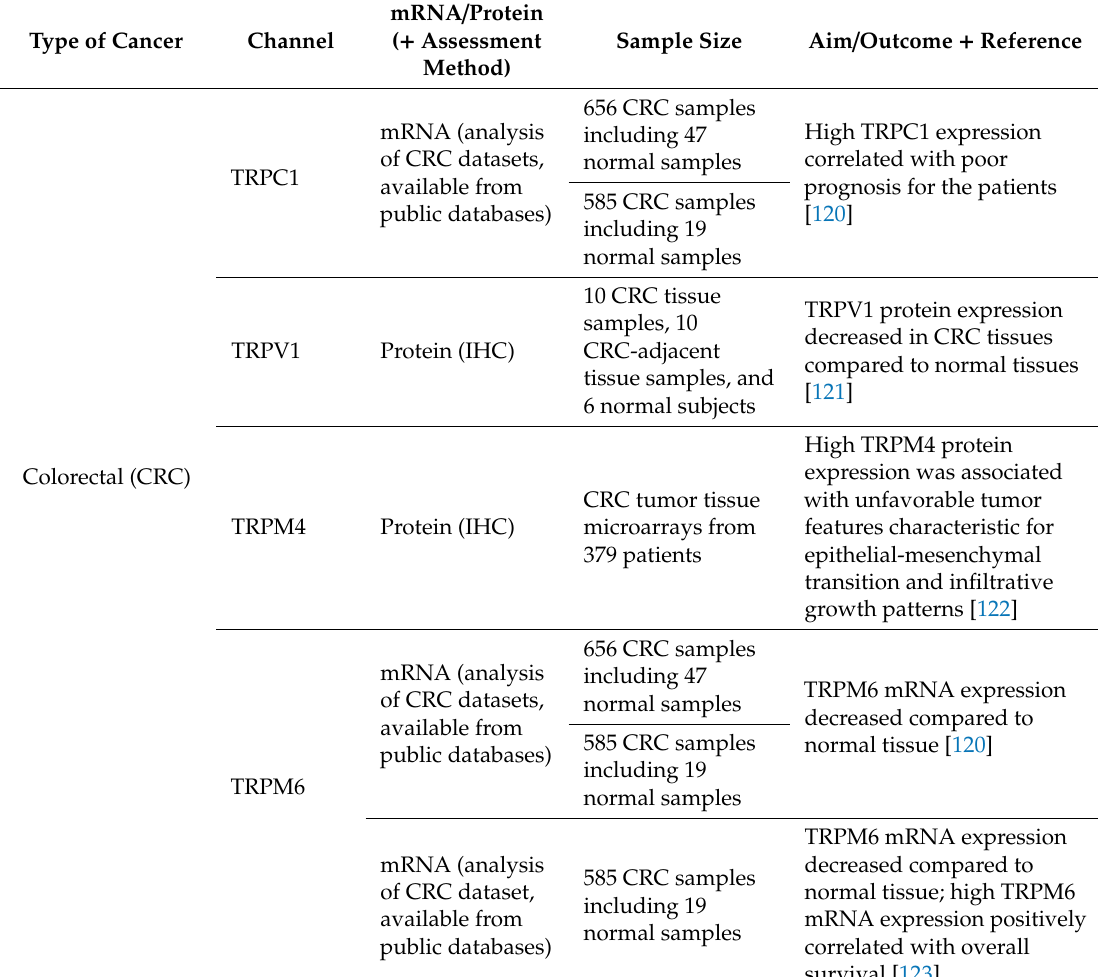
Table 6. Expression of TRP channels in human colorectal cancer (CRC)